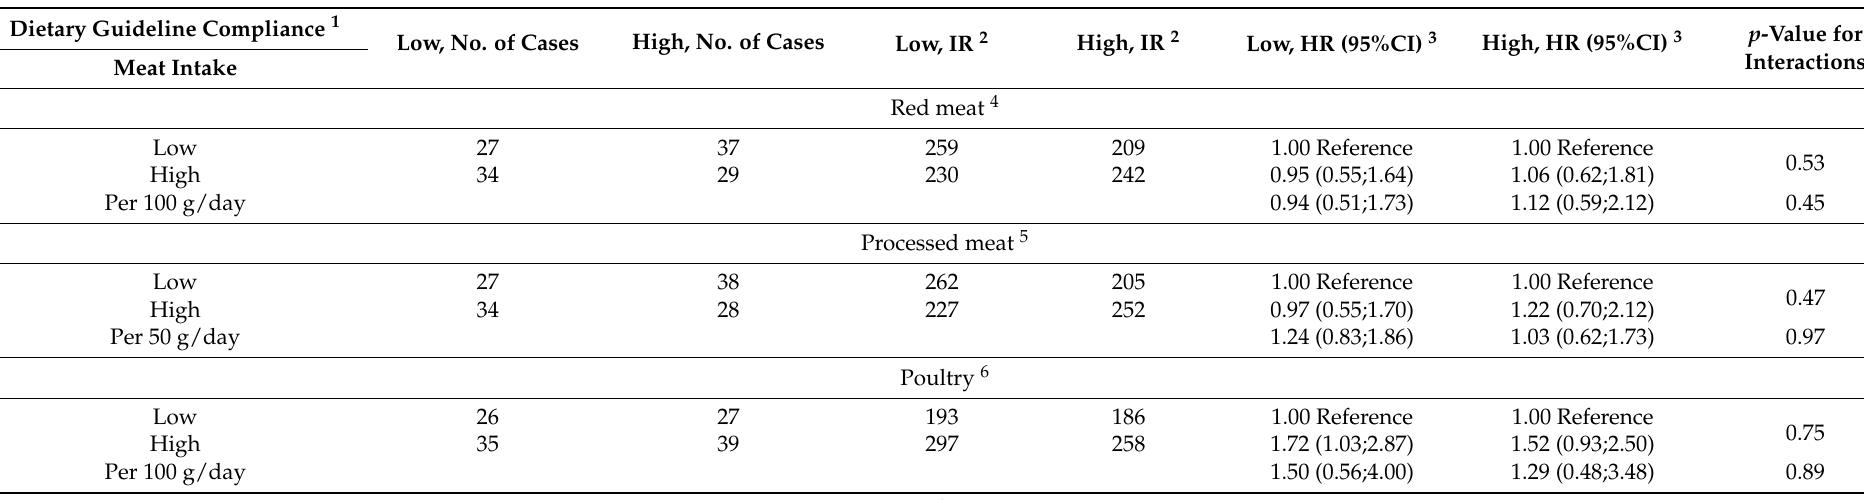
Table 7. Association between intake of different types of meat and risk of colorectal cancer. Stratified by dietary guideline compliance, n = 6282. Dietary Guideline Compliance